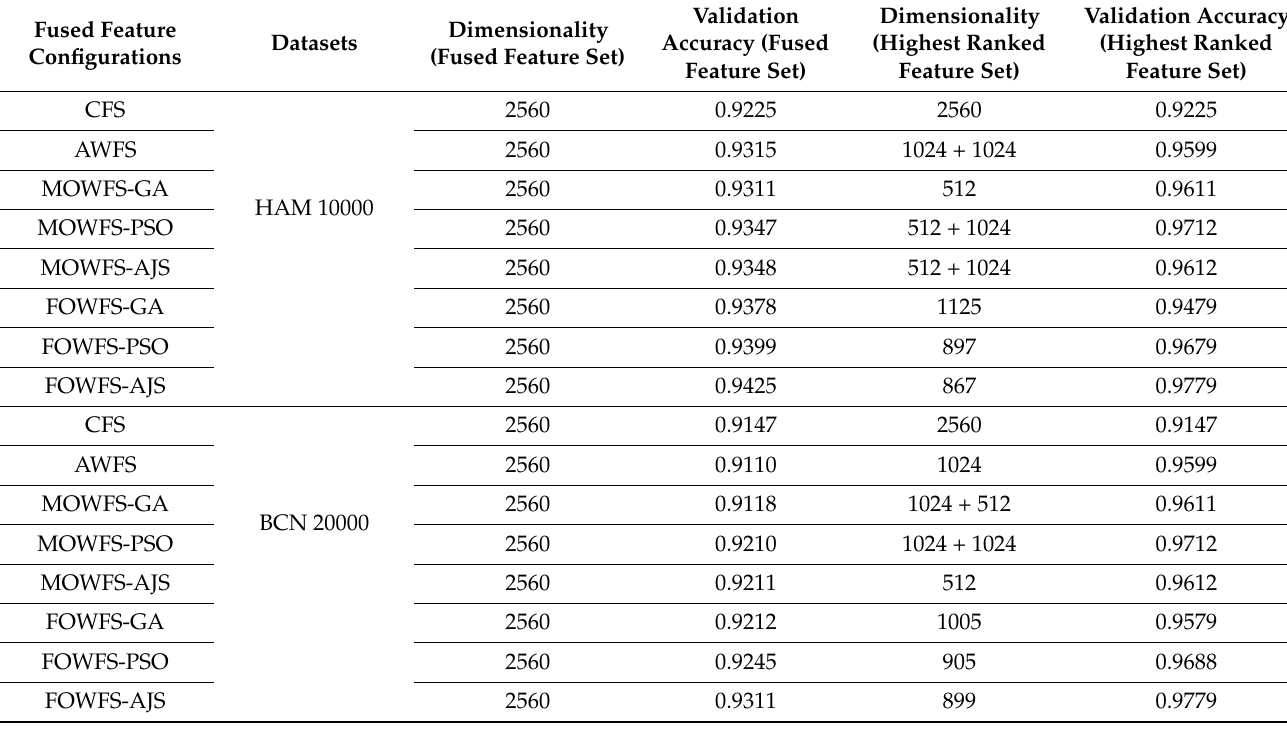
Table 7. Validation accuracy of fused feature sets vs. ranked feature sets based on